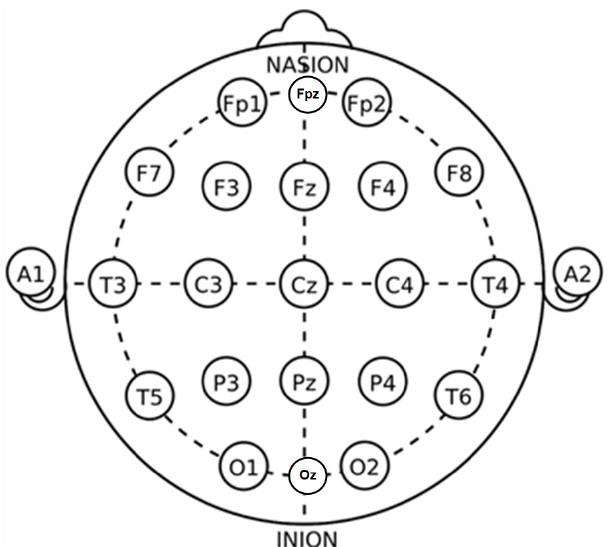
Figure 2. The position of electrodes of EEG acquisition system. The letters F, T, C, P, and O refer to the electrodes placed in the frontal, temporal, central, parietal, and occipital lobes, respectively. The recordings were divided into 30-s epochs, and each epoch was manually cate- gorized into one of the eight classes in accordance with the R and K standard by